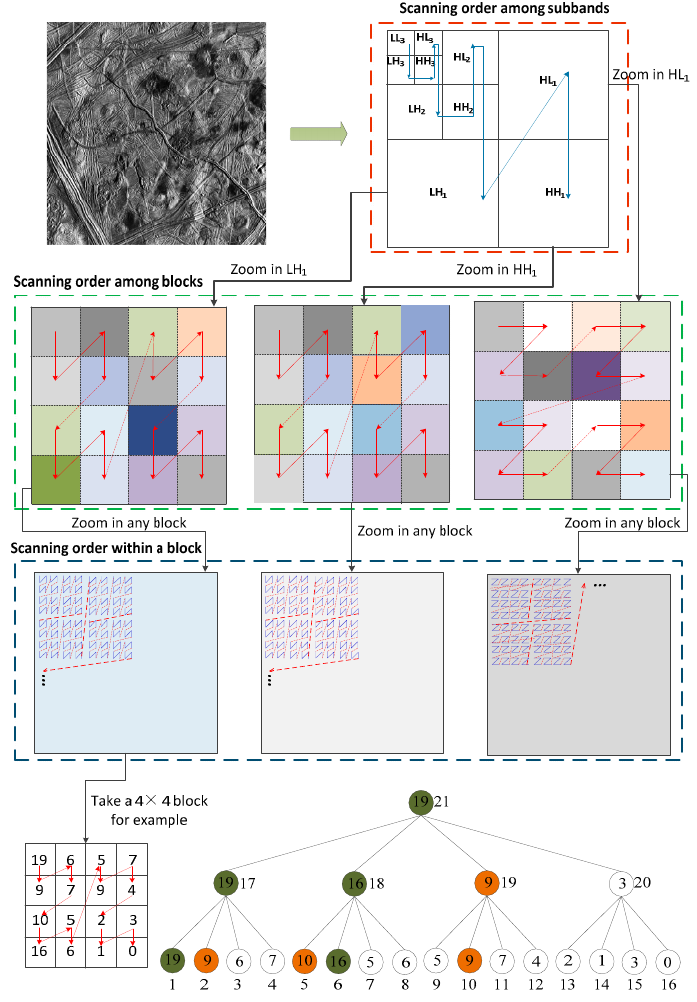
Figure 7. The adaptive scanning process of the test image.